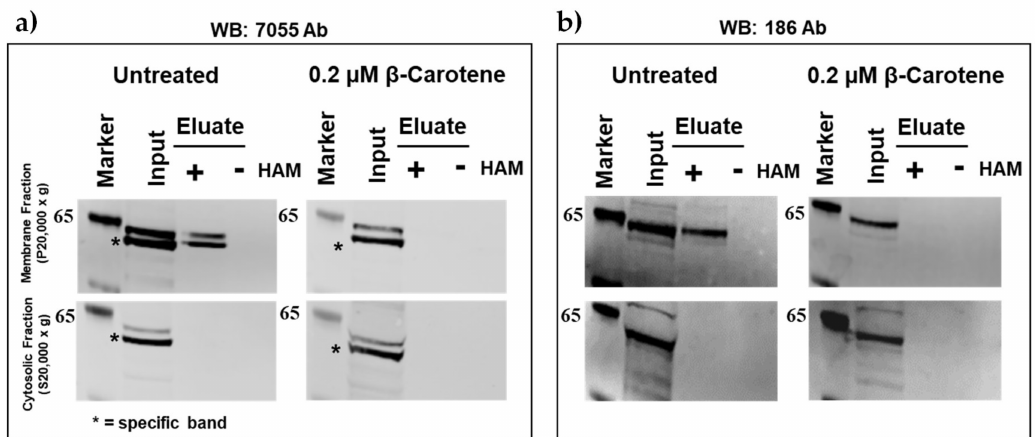
Figure 2. Detection of recombinant mBCO2 / V5 / Lumio protein palmitoylation by acyl-RAC